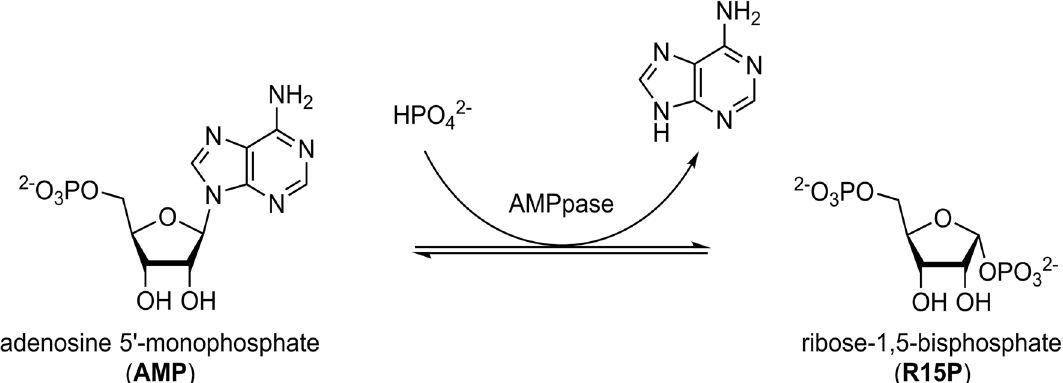
Figure 1. The reaction catalyzed by adenosine 5 ′ -monophosphate phosphorylases (AMPpases). The N -glycosidic bond of adenosine 5 ′ -monophosphate (AMP) is cleaved in the presence of inorganic phosphate yielding adenine and ribose-1,5-bisphosphate